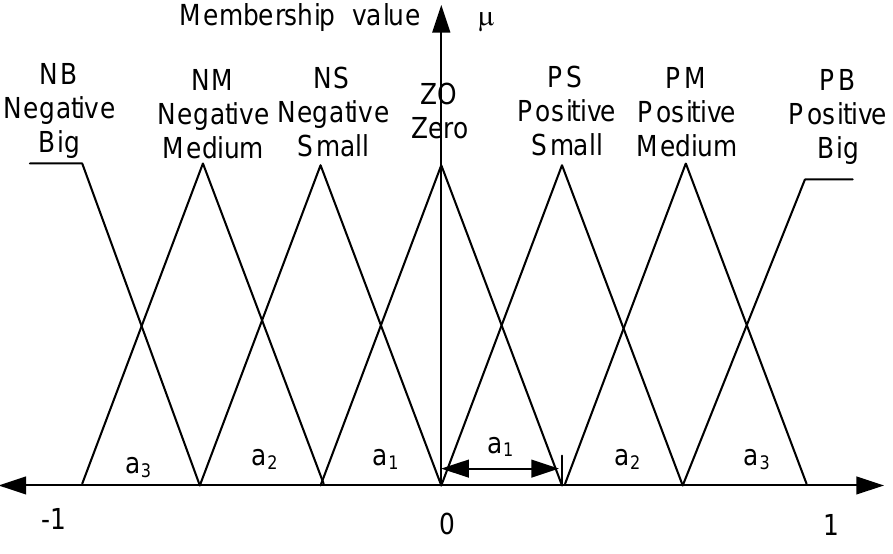
Figure 6. The normalized membership functions for the FLC inputs and output.